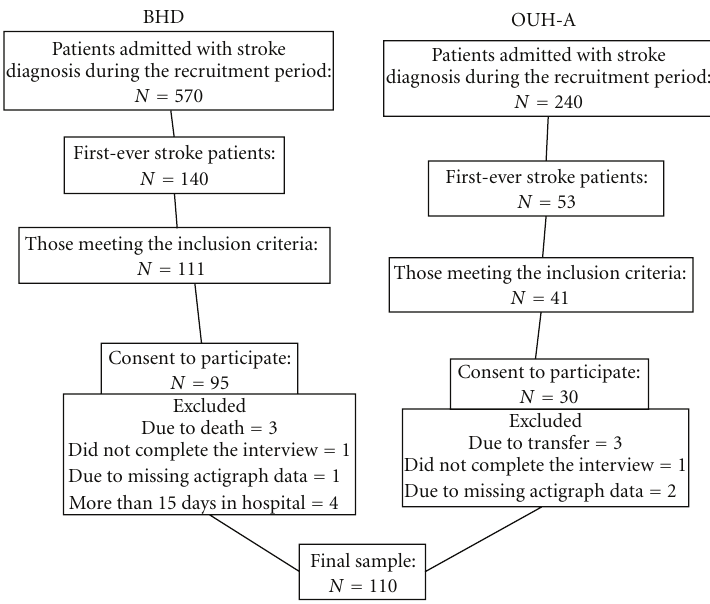
Figure 1: Flow chart for the sample